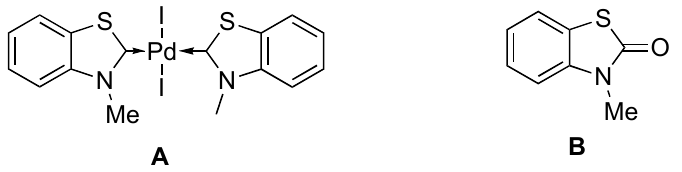
Figure 20. Carbene palladium precatalyst (A) and 2-oxo-3-methylbenzothiazole